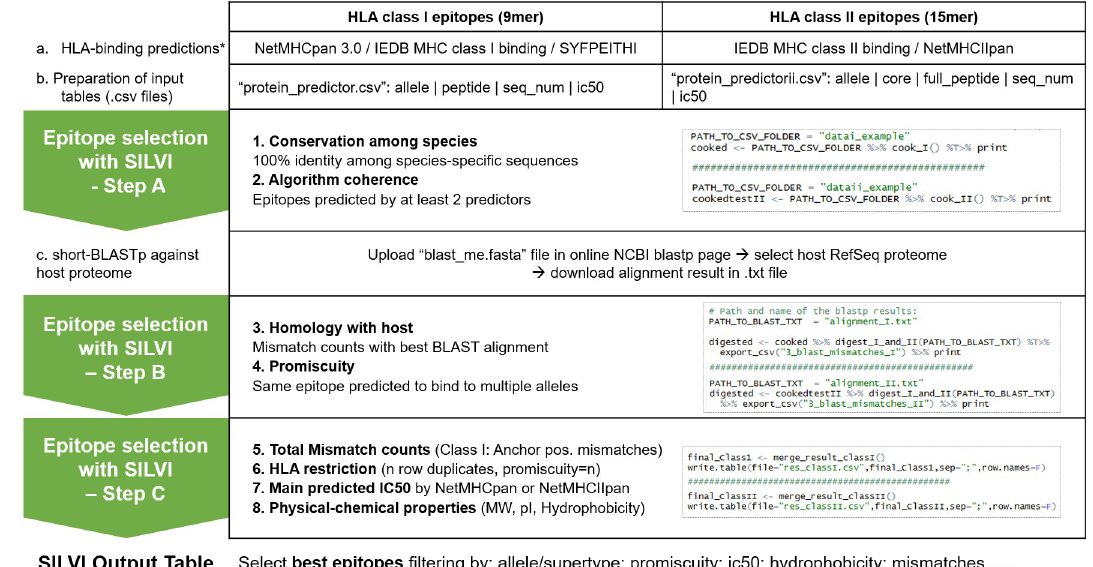
Fig 5. SILVI’s computer-based pipeline for T-cell epitope selection. Steps in black (a. to c.) are user-dependent; steps in green (“Epitope selection with SILVI–Step A to C”) are automatically applied by the script. � Users input protein sequences in web-based algorithm interfaces and export